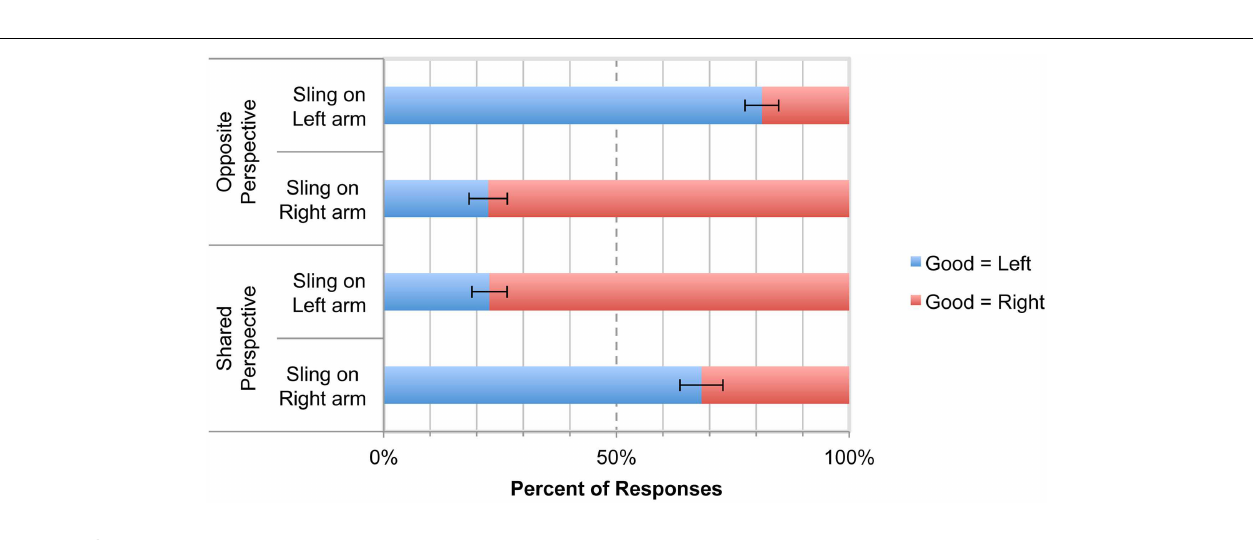
50% represents chance responding. “Good = Left” and “Good = Right” are coded from the participant’s perspective. Error bars indicate